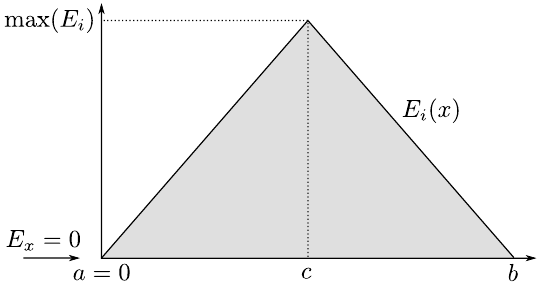
Figure 1. Triangular barrier profile where the carrier impinges on the barrier with E x = 0. If the carrier suceeds in traversing the barrier, it exits at the point x = b with the same